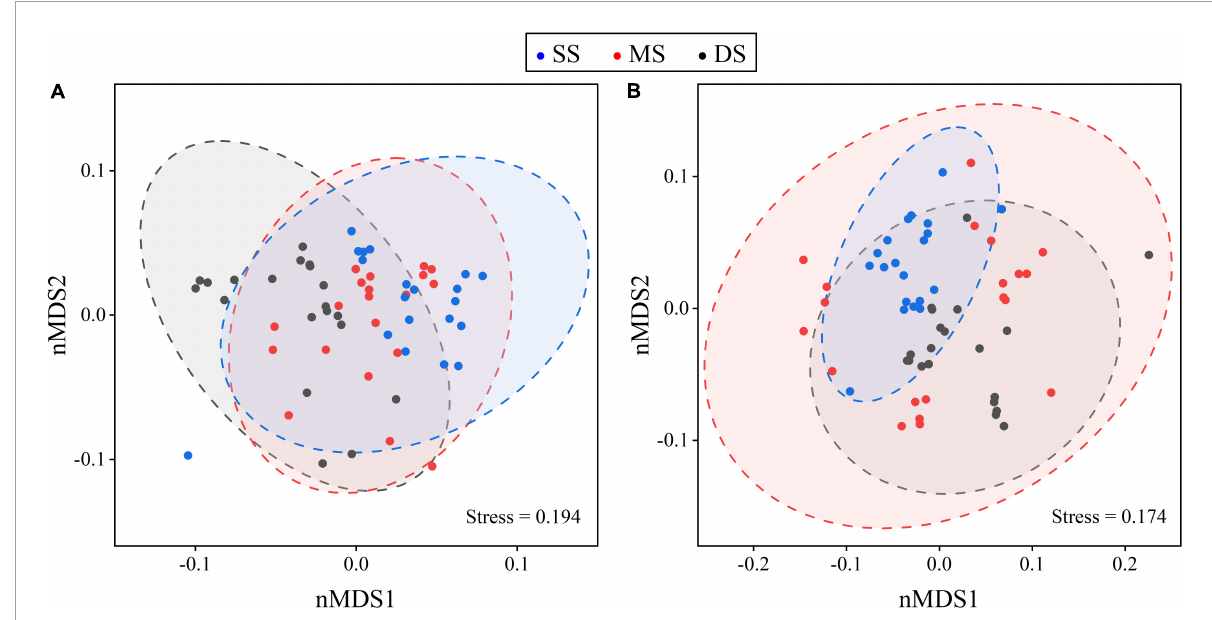
FIGURE4 Non-metric multidimensional scaling (nMDS) analysis of plant C, N, and P stoichiometry and soil factors for Taxodium ascendens (A) and Taxodium distichum (B) under different submergence treatments. Ellipses show a 95% confidence interval for each submergence treatment.